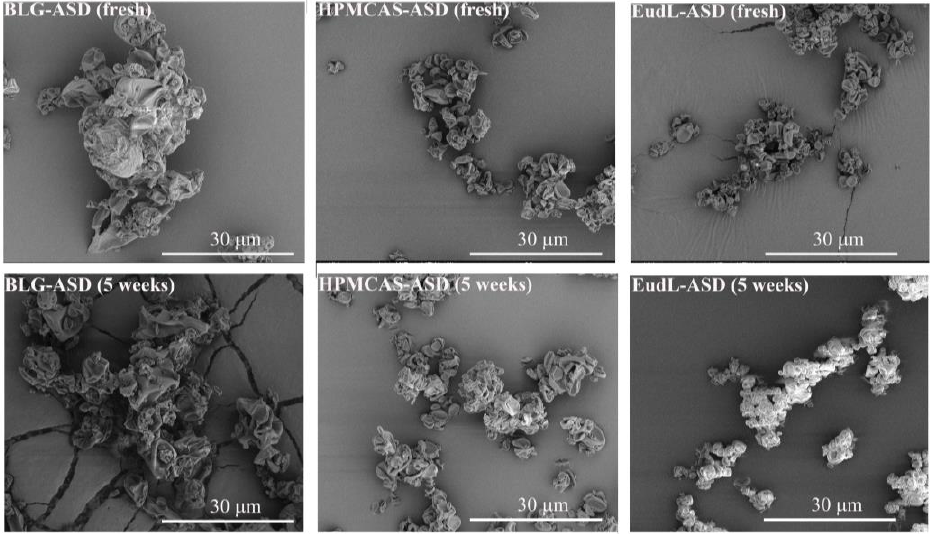
Figure 3. SEM images of the freshly prepared samples and the ASD samples stored for 5 weeks at accelerated conditions.